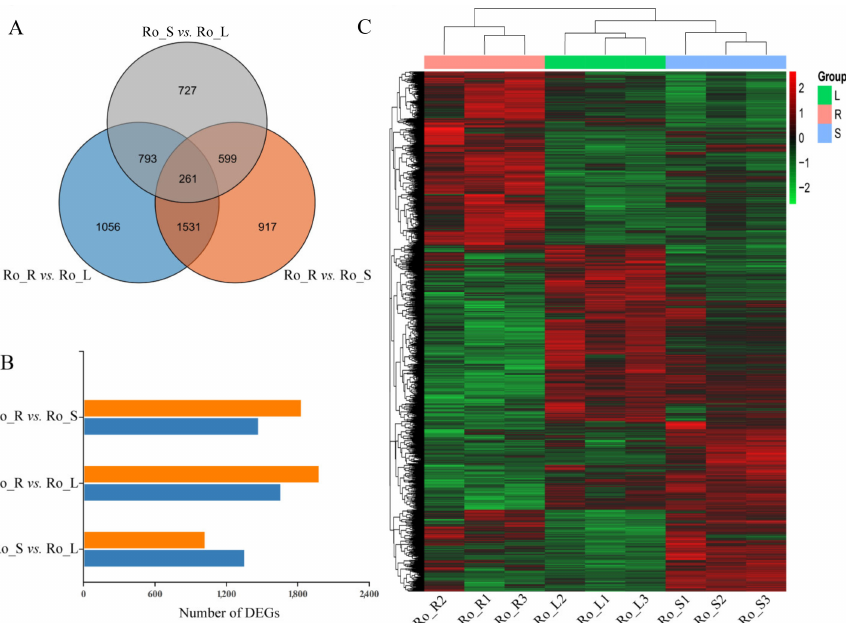
Figure 2. ( A ) Venn diagram of DEGs in the three comparison groups. The three circles represent different comparison groups, and their overlaps indicate the number of common DEGs identified in these comparison groups. ( B ) Number of DEGs in the three comparison groups. The orange rectangles indicate the up-regulated DEGs and the blue rectangles indicate the down-regulated DEGs. ( C ) The hierarchical cluster analysis of DEGs from three comparison groups of different tissues. The rows in the graph represent DEGs, the columns represent samples, and the colors are log-transformed and normalized to the FPKM values. The brighter color represents a higher (red) or lower (green) expression